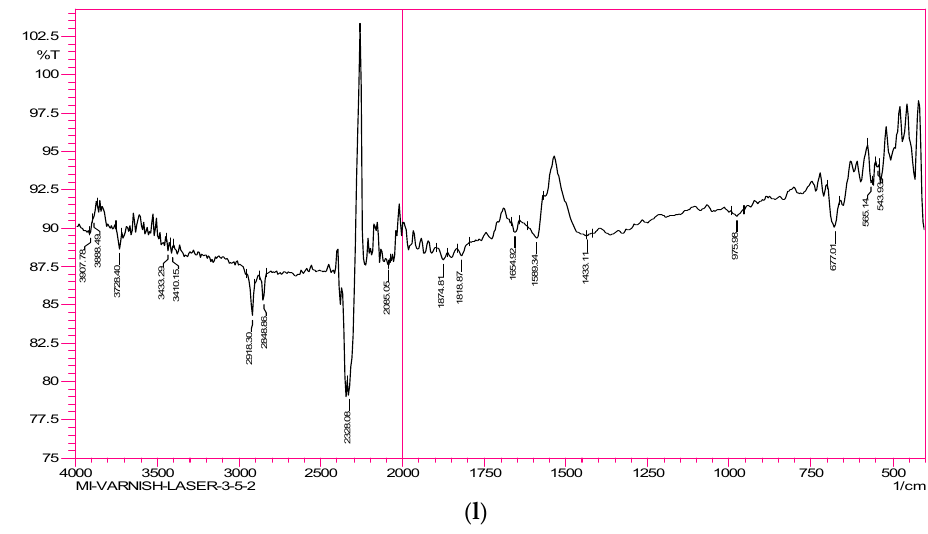
Figure 2. ( a ) Control. ( b ) Demineralized sample. ( c ) Laser 1 Watt. ( d ) Laser 2 Watts. ( e ) Laser 3 Watts. ( f ) Laser 3.5 Watts. ( g ) CPP-ACPF. ( h ) CPP-ACPF & Laser 3.5 Watts. ( i ) Enafix. ( j ) Enafix & Laser 3.5 Watts. ( k ) MI Paste. ( l ) MI Paste & Laser 3.5 Watts. Group 2—Demineralized samples: The weak peak observed at 1051 cm − 1 corresponds to carbonate. The peak/band representing phosphate disappeared. The peaks for organic matter appeared in the region of 2848 and 2916 cm − 1 . The broad band representing the hydroxyl group that is due to moisture content also disappeared. The carbonyl stretching band has disappeared (Figure 2b). Group 3—Laser 1 Watts samples: The weak peak observed at 1037 cm − 1 corresponds to carbonate. The peak/band representing phosphate disappeared. The peaks for organic matter appeared in the region of 2848 and 2916 cm − 1 . The broad band representing the band has disappeared (Figure 2c).